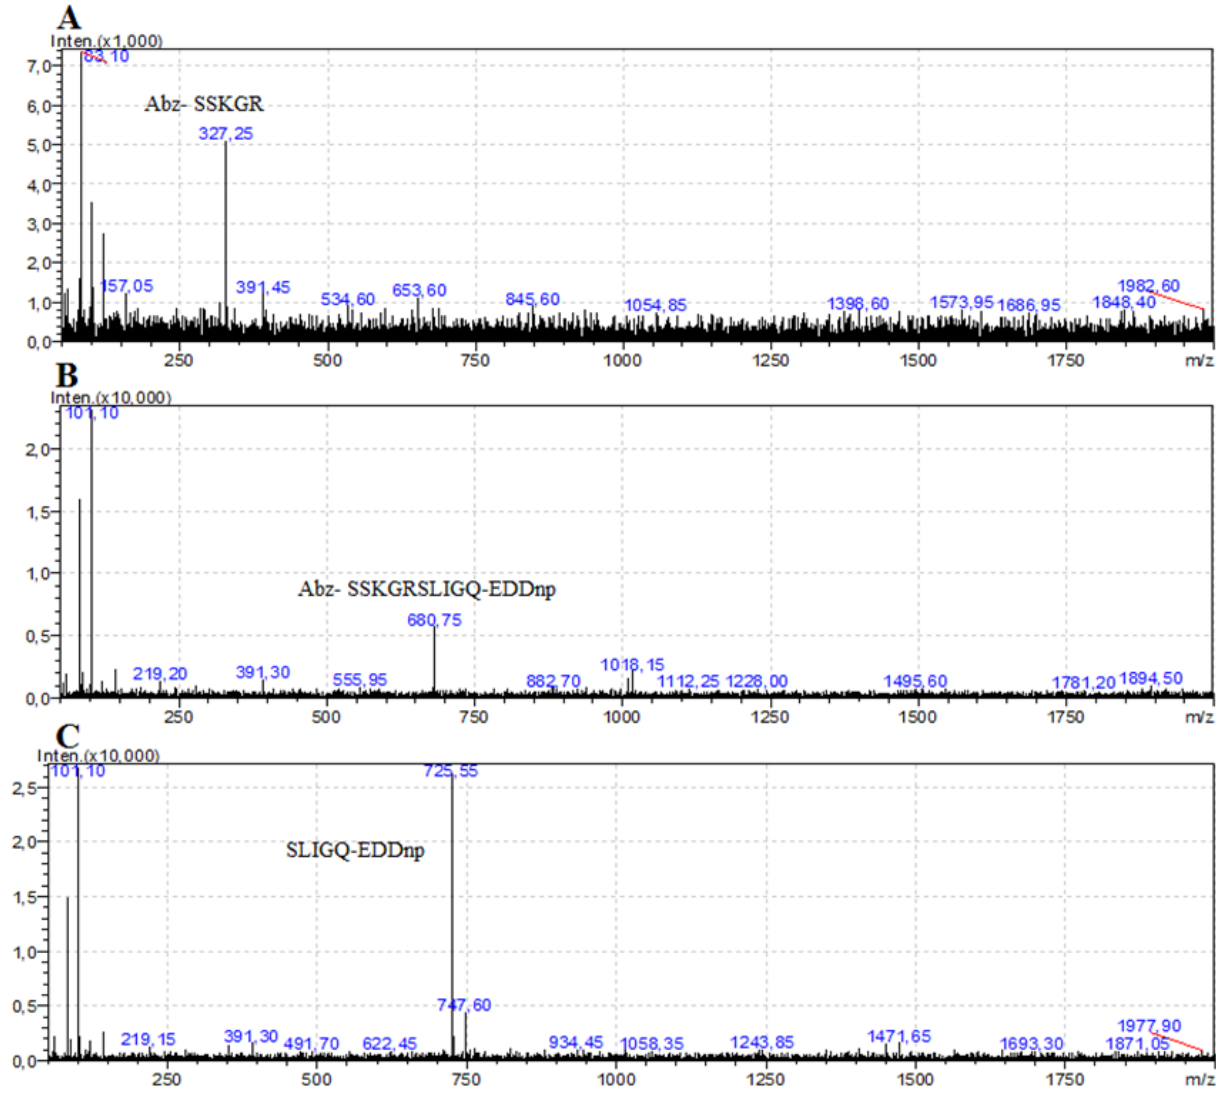
Figure 2. Mass spectrum of PAR-2 cleavage products generated by T. infestans saliva . PAR-2 peptide was treated for 30 min at 37 °C with T. infestans saliva in 100 mM Tris-HCl buffer (pH 8.0). The amino acid sequences of the fragments are indicated in A, B and C. (A) Molecular ion at m/z 327.5 corresponds to m/z of the peptide Abz-SSKGR. (B) Molecular ion at m/z 680.75 corresponds to m/z of the peptide Abz-SSKGRSLIGQ-EDDnp. (C) Molecular ion at m/z 725.5 corresponds to SLIGQ-EDDnp molecular